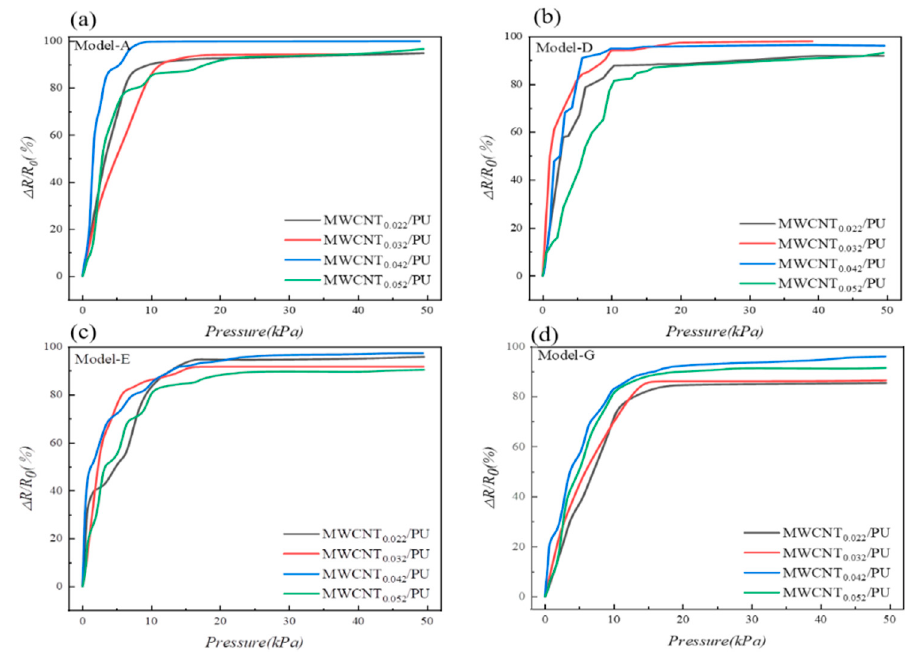
Figure 8. Effect of MWCNT content on pressure-response of different models. ( a ) Model − A, ( b ) Model − D, ( c ) Model − E, and ( d ) Model − G.